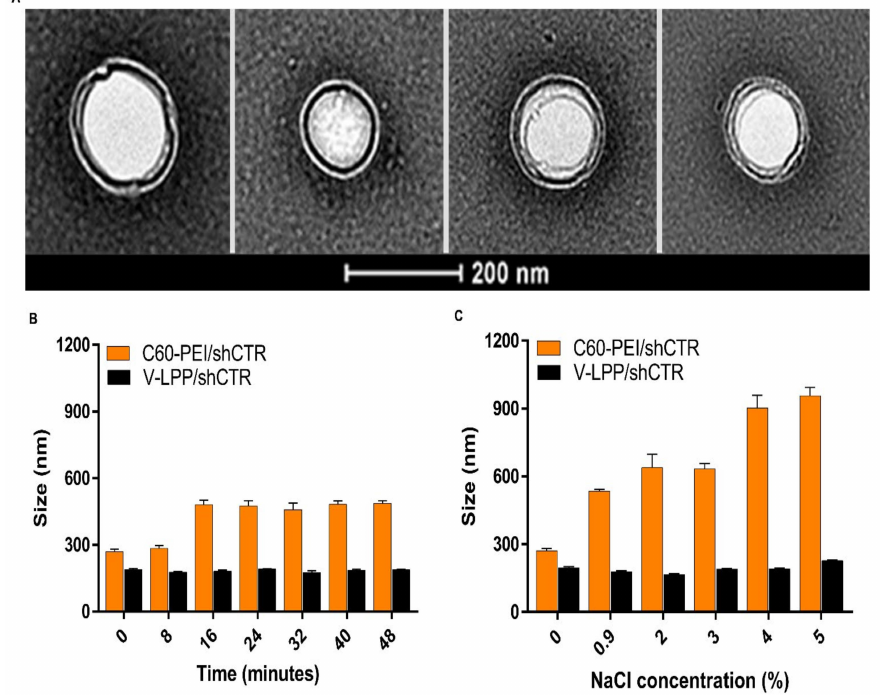
Figure 3. Characterization of VCAM-1 targeted lipopolyplexes encapsulating the shRNA plasmid. ( A ) Electron micrographs of negatively-stained V-LPP/shCTR lipopolyplexes showing its spherical morphology. ( B ) Colloidal stability of C60-PEI/shCTR polyplexes and V-LPP/shCTR lipopolyplexes in PBS determined by DLS. ( C ) Electrolyte-induced flocculation of C60-PEI/shCTR polyplexes and V-LPP/shCTR lipopolyplexes. Note the stability of V-LPP/shCTR lipopolyplexes in comparison with C60-PEI/shCTR polyplexes. Results are reported as mean ± S.D. for three individual